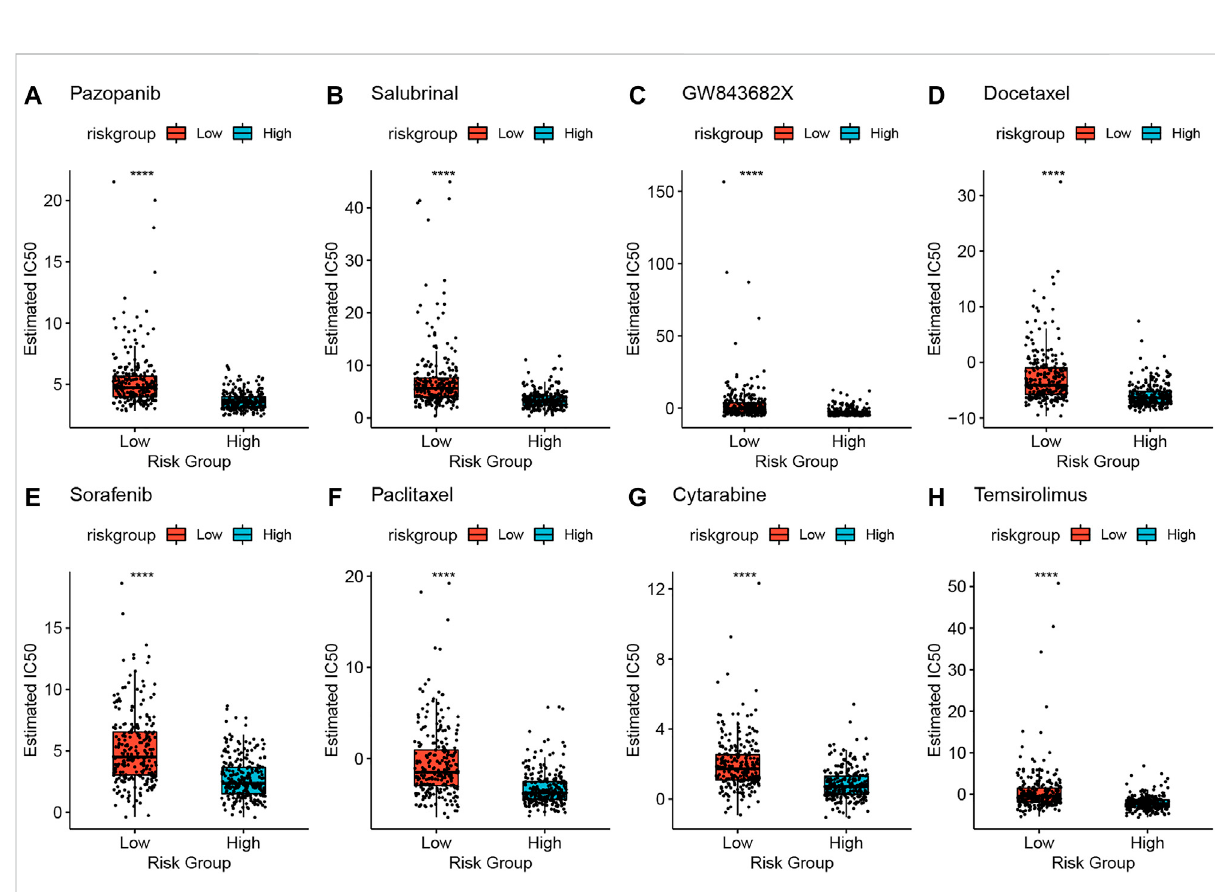
FIGURE 9 High-risk and low-risk groups respond differently to the eight drugs (A – H) . * p < 0.05, ** p < 0.01, *** p < 0.001, **** p <